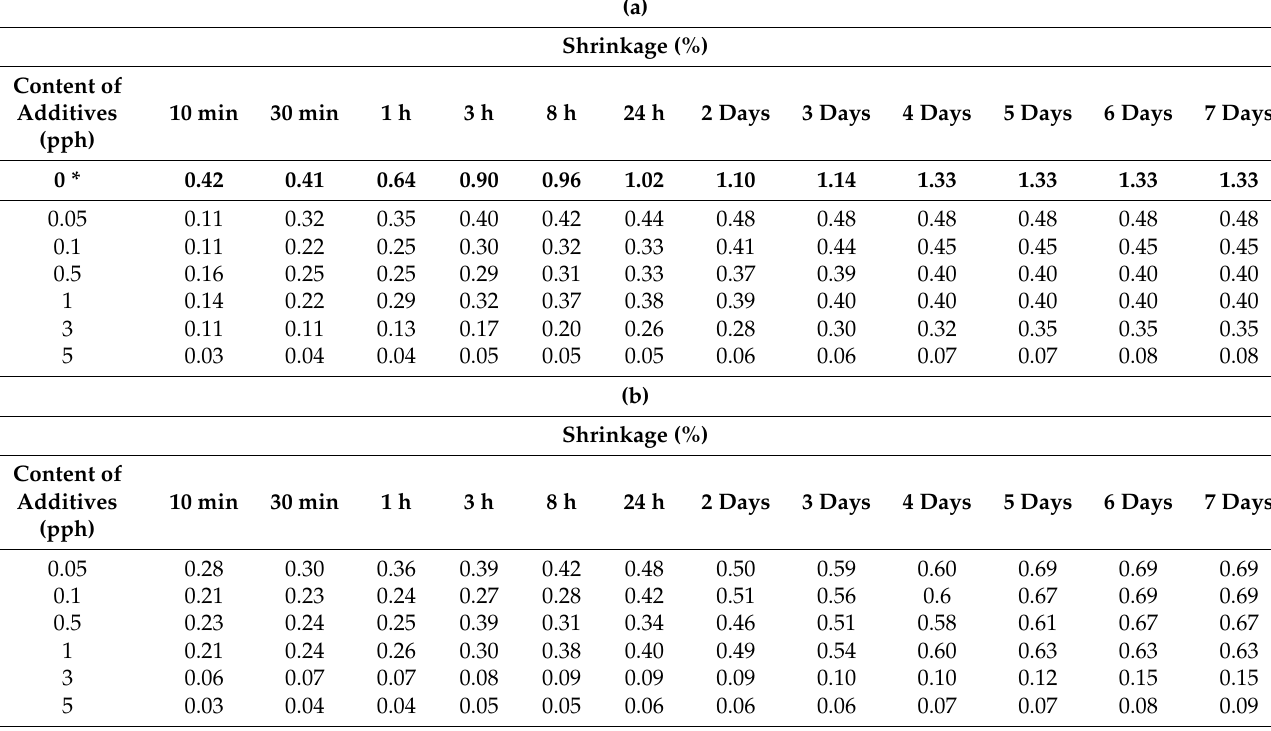
Table 4. Shrinkage of pressure-sensitive adhesives: marked with 0—adhesive without